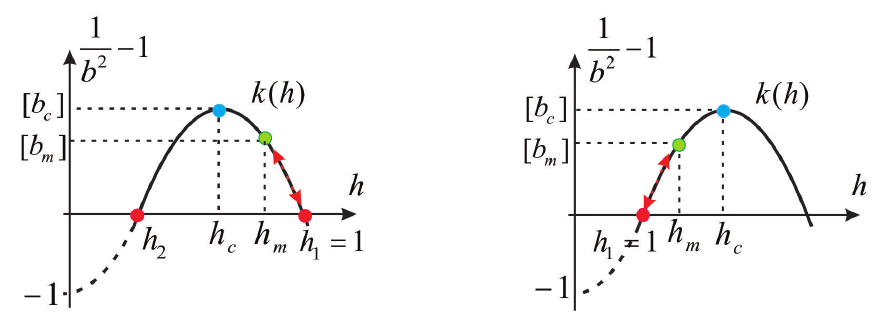
Figure 4. The energy curve k (( h ) as a function of 1/ b 2 − 1: ( left ) the subcritical case and ( right ) the supercritical